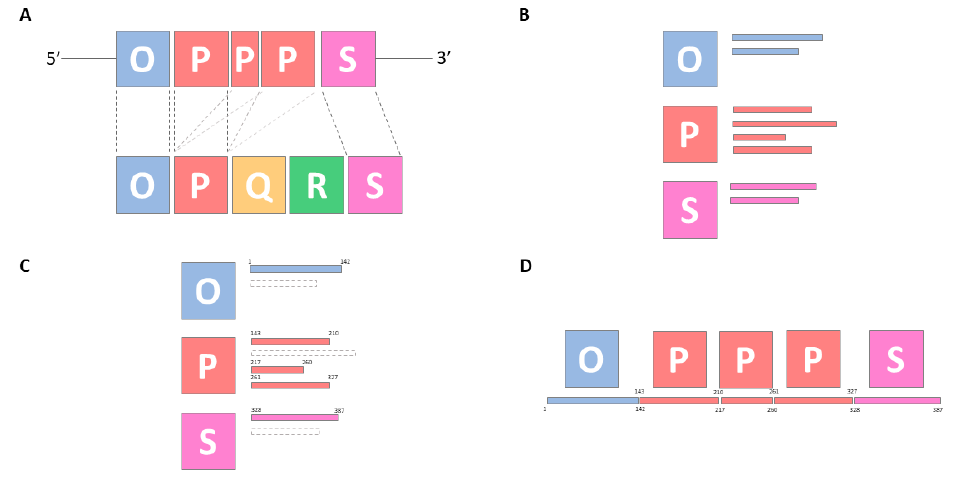
Figure 3. Graphical representation of BKTyper NCCR block identification using BKPyV Dunlop strain (V01108.1) . Subpanels ( A ) to ( D ) represent the different steps of the algorithm. ( A ) Alignment of the query sequence (upper blocks) to the BKTyper NCCR archive sequences (bottom blocks). ( B ) Collection of alignment hits (small rectangles) by block. Alignment hits can represent (i) off-target hits or (ii) sub-alignments (as displayed by arbitrary rectangles in subpanel ( B ). ( C ) Alignment hit filtering by similarity and alignment coordinates. ( D ) Reconstruction of the original sequence and typing reporting. NCCR regions are codified as blue for O, red for P, yellow for Q, green for R, and purple for S blocks.